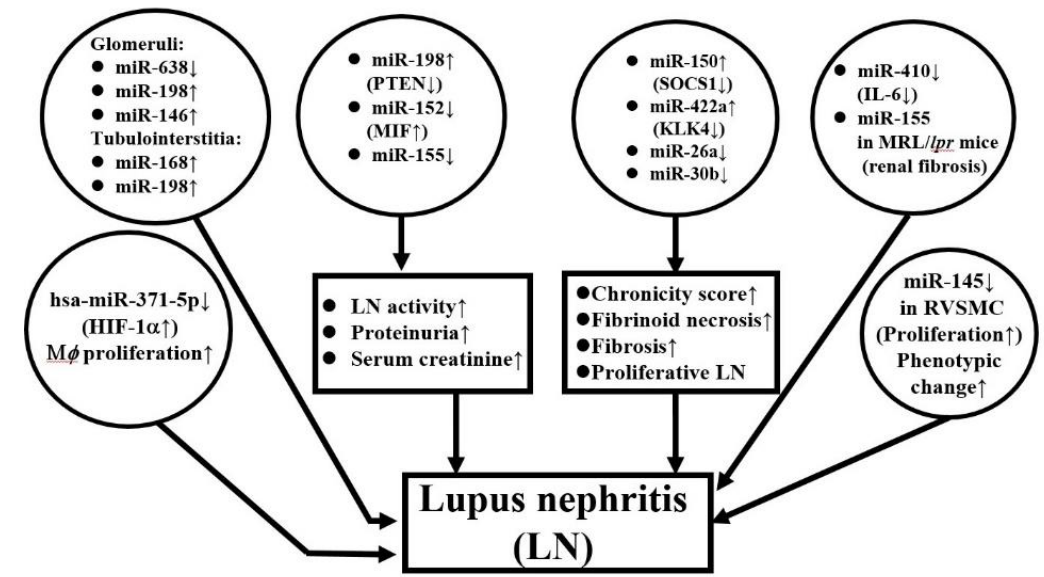
Figure 4. ncRNA expression in lupus nephritis tissue. hsa: Homo sapiens ; PTEN: Phosphatase and tensin homolog deleted on chromosome ten; MIF: Macrophage migration inhibitory factor; SOCS: Suppressor of cell signaling; HIF: Hypoxia-inducible factor; M ϕ : macrophage; RVSMC: rat vascular smooth muscle